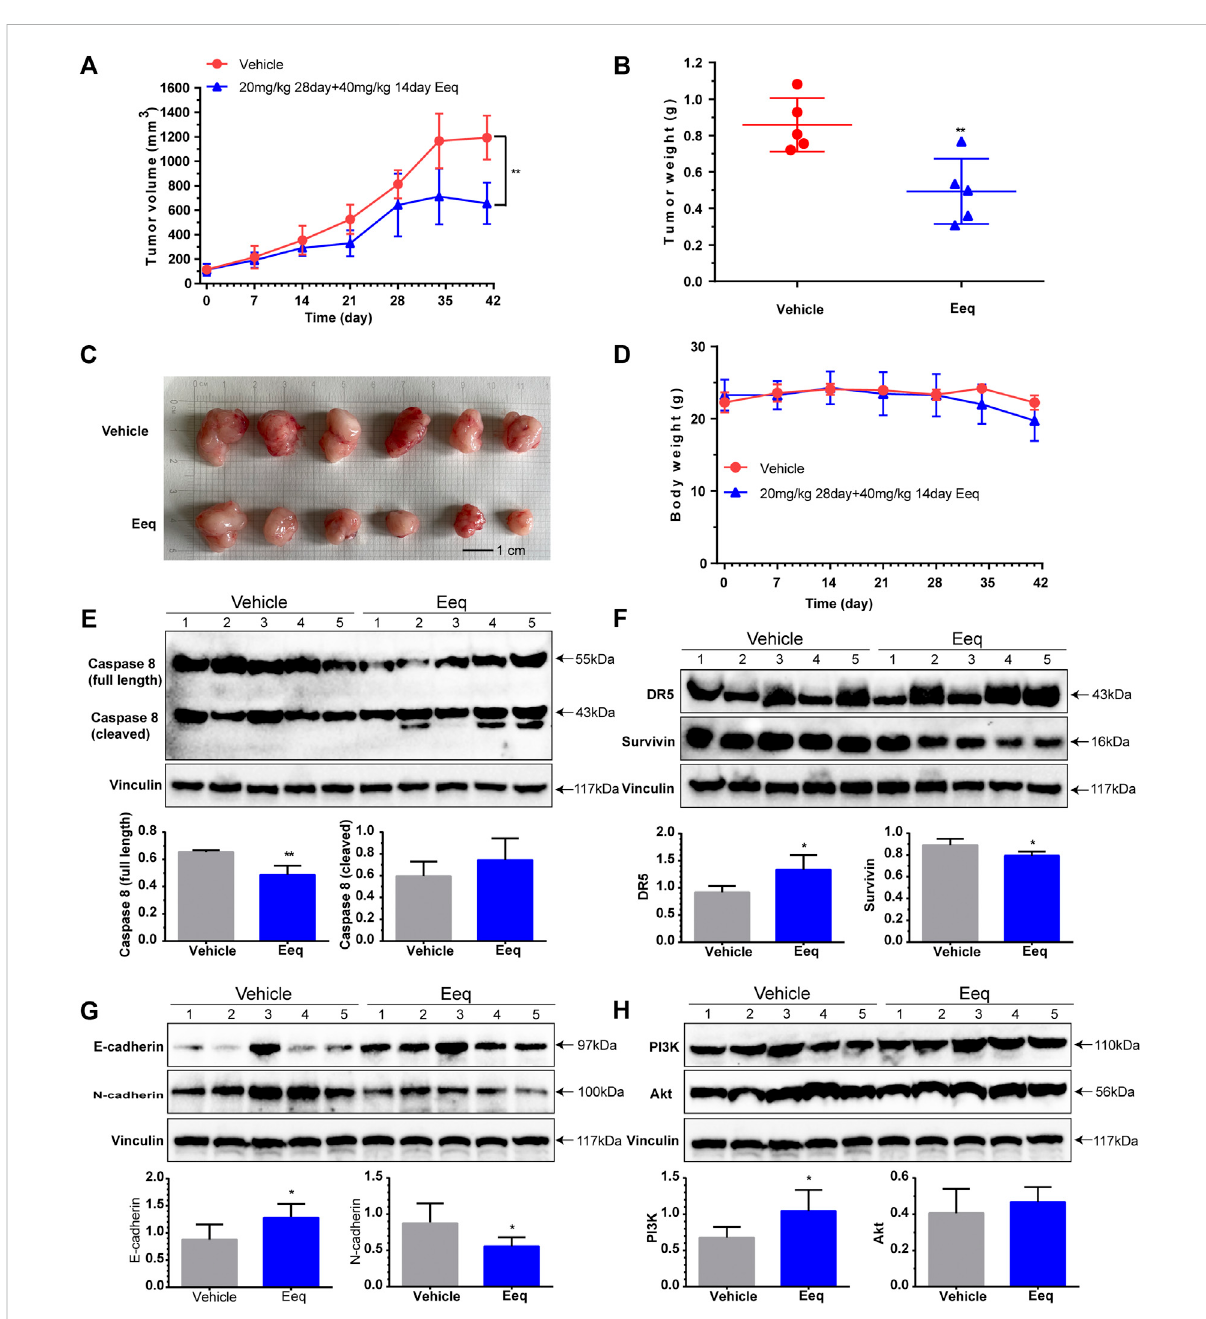
FIGURE 6 5 ′ -Epiequisetin(Eeq)suppressed prostate cancerdevelopment invivo . (A) Eeqreducedtumorvolumeinmice. (B) Eeqdecreasedtumorweight inmice. (C) Tumorsizeandappearanceinmice. (D) Bodyweightofmiceduringadministration. (E) Eeqregulatedtheexpressionofcaspase8protein in mice tumor tissue. (F) Eeq increased DR5 protein and decreased survivin protein expression in mice tumor tissue. (G) Eeq increased E-cadherin proteinanddecreasedN-cadherinproteinexpressioninmicetumortissue. (H) Eeqhadnosigni fi canteffectonPI3KandAktproteinexpression in tumor tissue of mice. * p < 0.5, ** p < 0.01 vs .